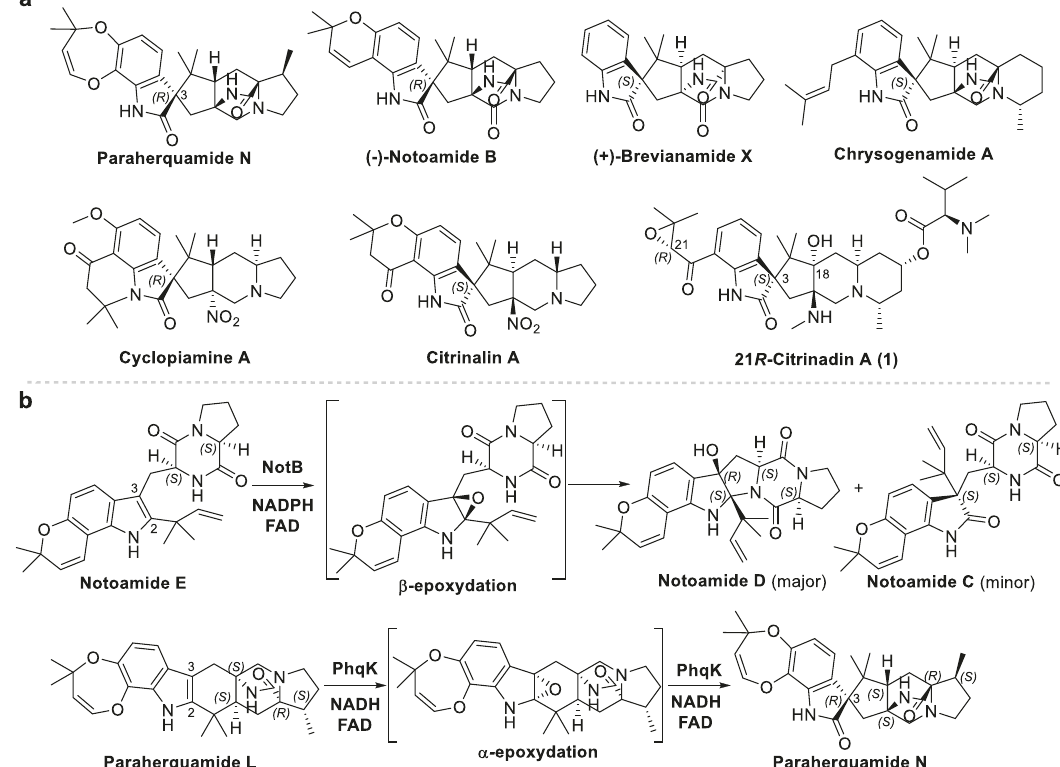
Fig. 1 Representative 3 R - and 3 S -spirooxindole PIAs and FPMOs. a Spirooxindole PIAs contain or lack the bicyclo[2.2.2]diazaoctane ring. b FPMO- catalyzed facial selective indole 2,3-epoxidations on